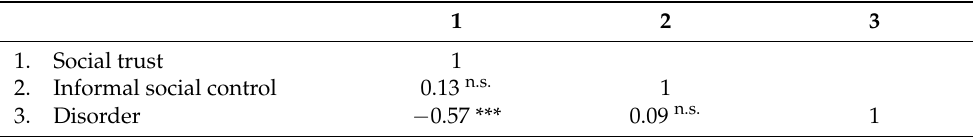
Table 2. Bivariate correlations of neighborhood-level variables ( N = 142).